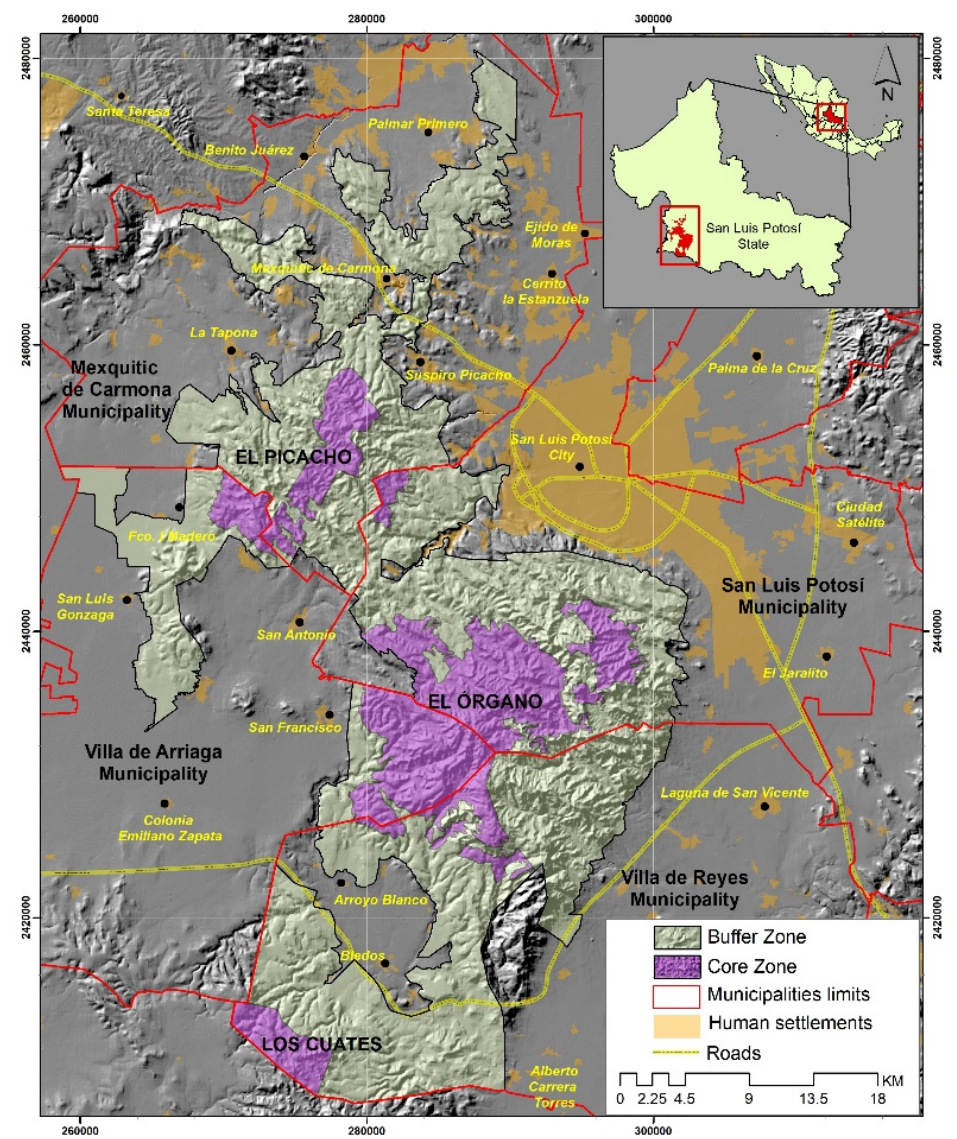
Figure 4. Map of core zones of the Protected Natural Area Sierra de San Miguelito, San Luis Potosi.